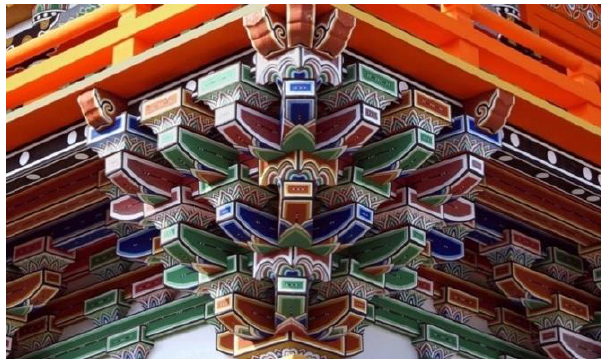
Figure 1. Dougong architecture.